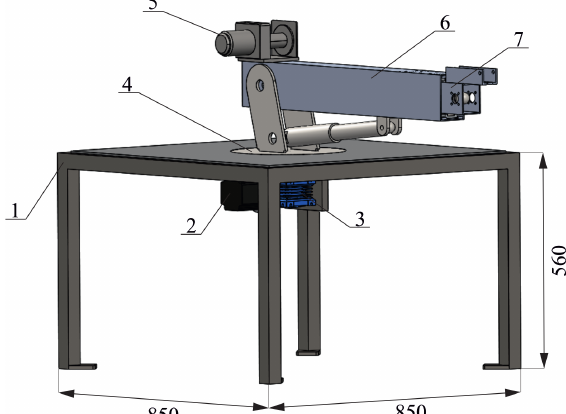
Figure 2. Schematic diagram of the designed laboratory crane (main components).